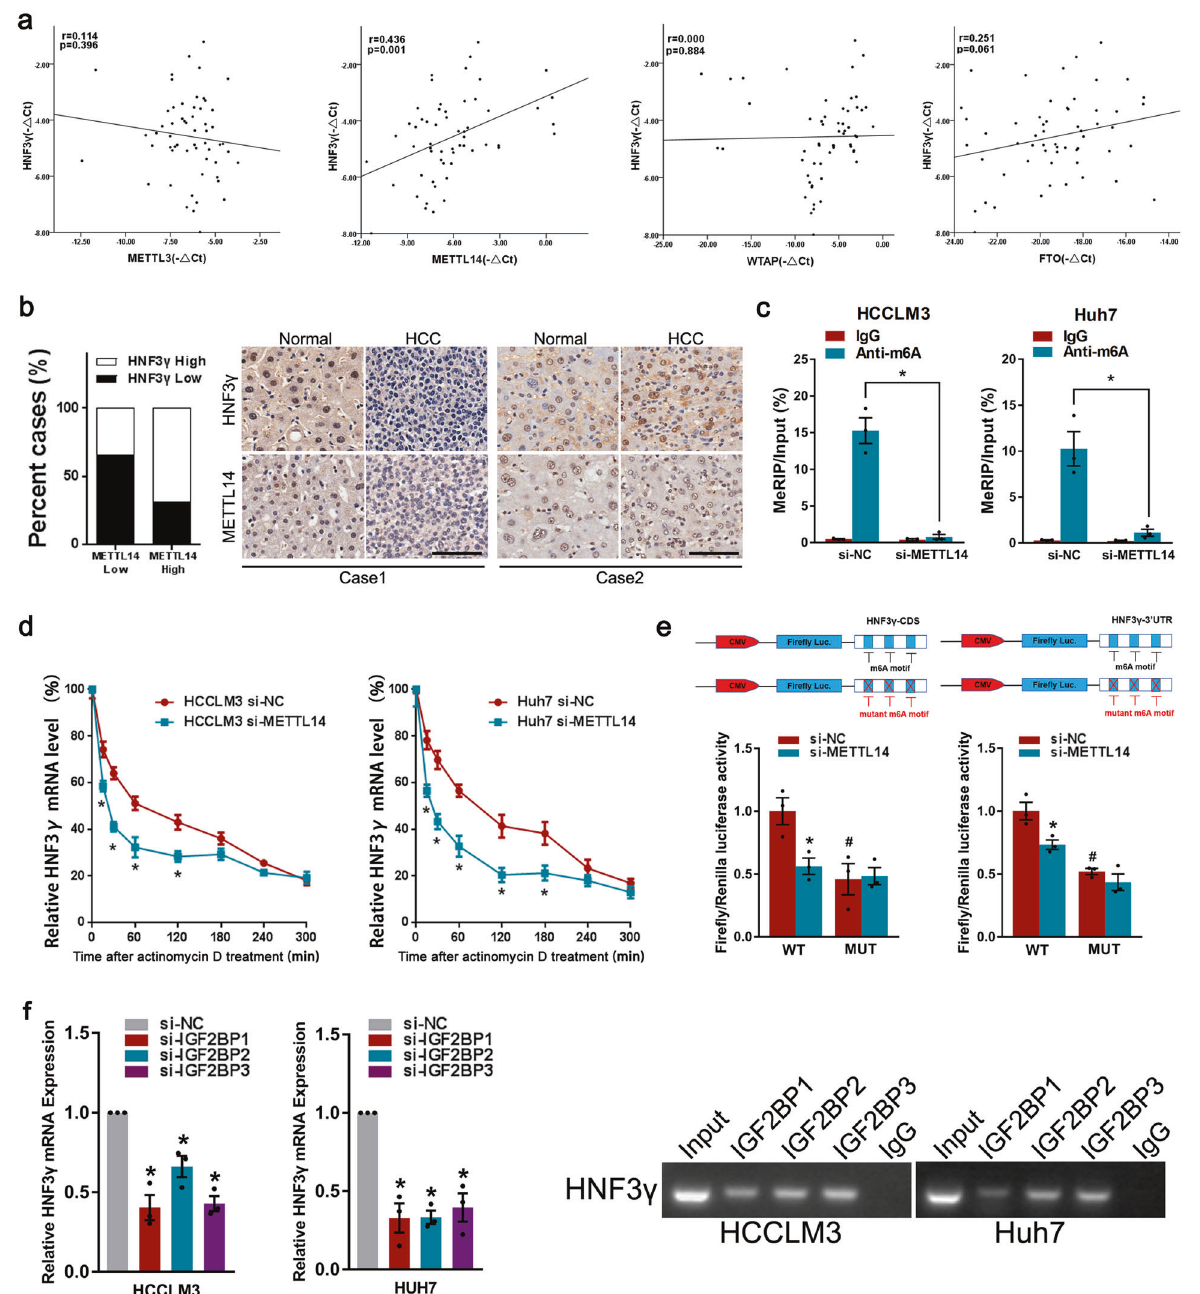
Fig. 3 M6A analysis of HNF3 γ mRNA in HCC. a The correlation between HNF3 γ levels and METTL3, METTL14, WTAP, or FTO expression in HCC tissues was evaluated in 57 HCC specimens by Pearson ’ s correlation analysis. b The correlation between HNF3 γ levels and METTL14 expression in HCC tissues from Cohort 1 was evaluated using a chi-square test. Representative IHC staining images are shown. Scale bar, 100 μ m. c HCCLM3 and Huh7 cells were transfected with si-NC or siMETTL14 and then subjected to immunoprecipitation of m6A-modi fi ed RNA followed by real-time PCR analysis. d To analyze the effect of METTL14 on HNF3 γ mRNA degradation, HCCLM3 or Huh7 cells transfected with si-NC or si-METTL14 were incubated with actinomycin D (10 μ M) for 0, 15, 30, 60, 120, 180, 240, or 300 min. The levels of HNF3 γ mRNA were determined by real-time PCR and the values were normalized to time zero. e Relative luciferase activity of pMIR-REPORT-HNF3 γ -CDS (left panel) and pMIR-REPORT-HNF3 γ -3 ′ UTR (right panel) with either wild-type or mutant (A-to-T mutation) m6A sites in HCCLM3 cells co- transfected with si-NC or si-METTL14, respectively. Fire fl y luciferase activity was measured and normalized to Renilla luciferase activity. Results were expressed as means ± SEM. * Indicates the signi fi cant difference between WT + si-NC group and WT + si-METTL14 group. # Indicates the signi fi cant difference between WT + si-NC group and MUT + si-NC group. See Supplementary materials for the details. f The expression of HNF3 γ in HCCLM3 or Huh7 cells transfected with si-NC or si-IGF2BP1/2/3 was determined by real-time PCR. g RIP assay was carried out using anti-IGF2BP1/2/3 antibodies. The RNA was extracted from protein G-agarose with anti-IGF2BP1/2/3 antibody, or with control IgG. The speci fi c anti-IGF2BP1/2/3 binding mRNA regions of HNF3 γ were ampli fi ed by